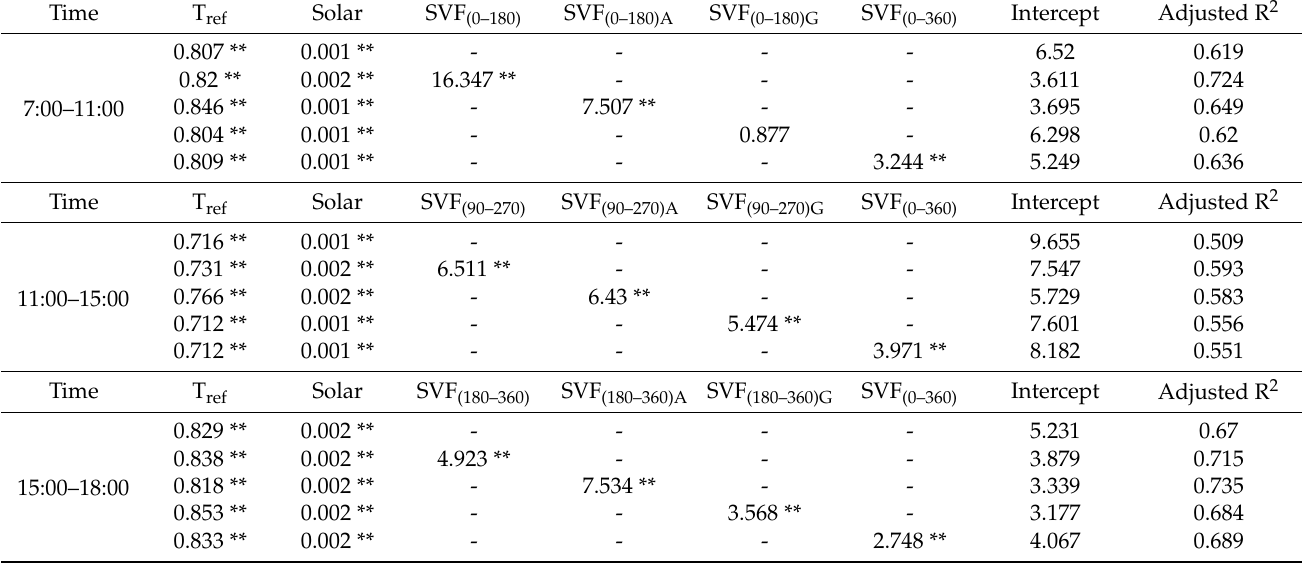
Table 7. Regression results of